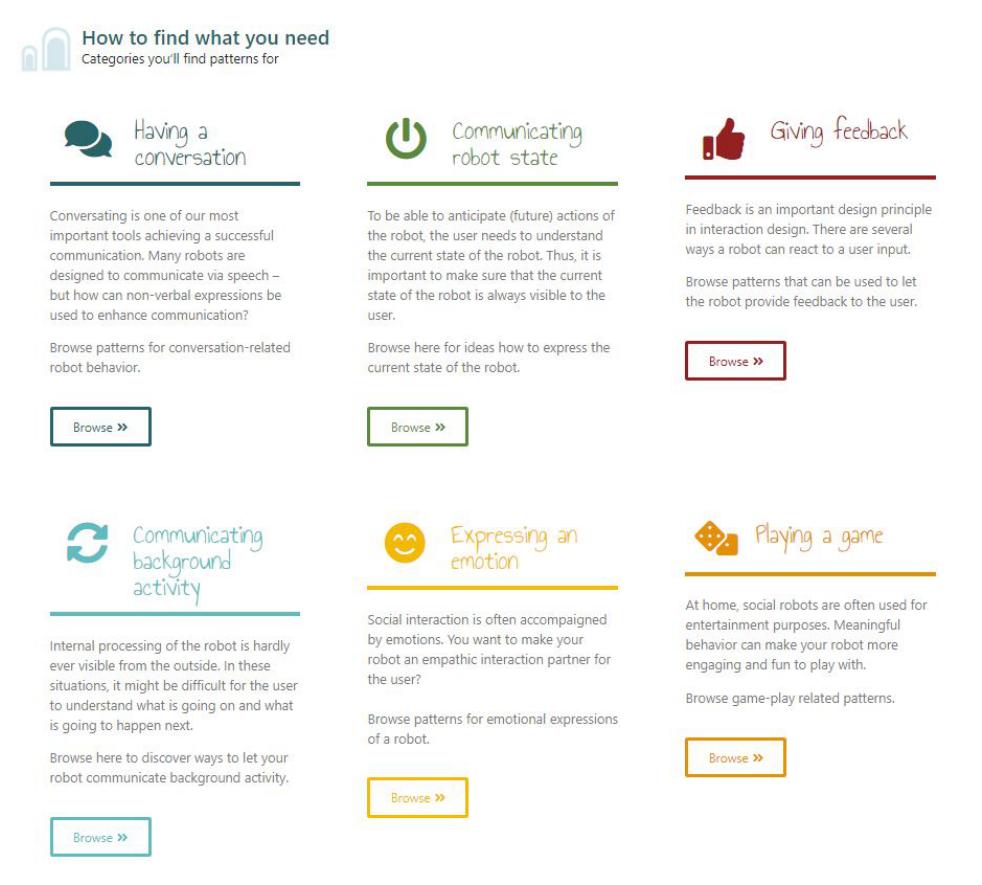
Figure 9. Screenshot of the pattern categories provided in the Robot Behavior Pattern